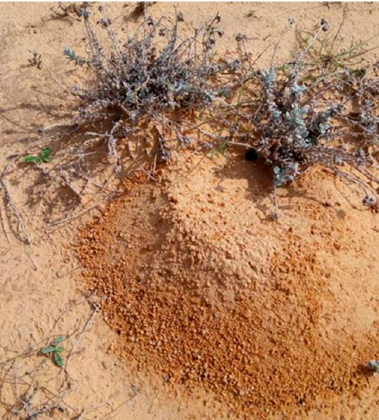
Figure 9. Soil as a habitat: ant hill in Al Garabulli, Tripoli.